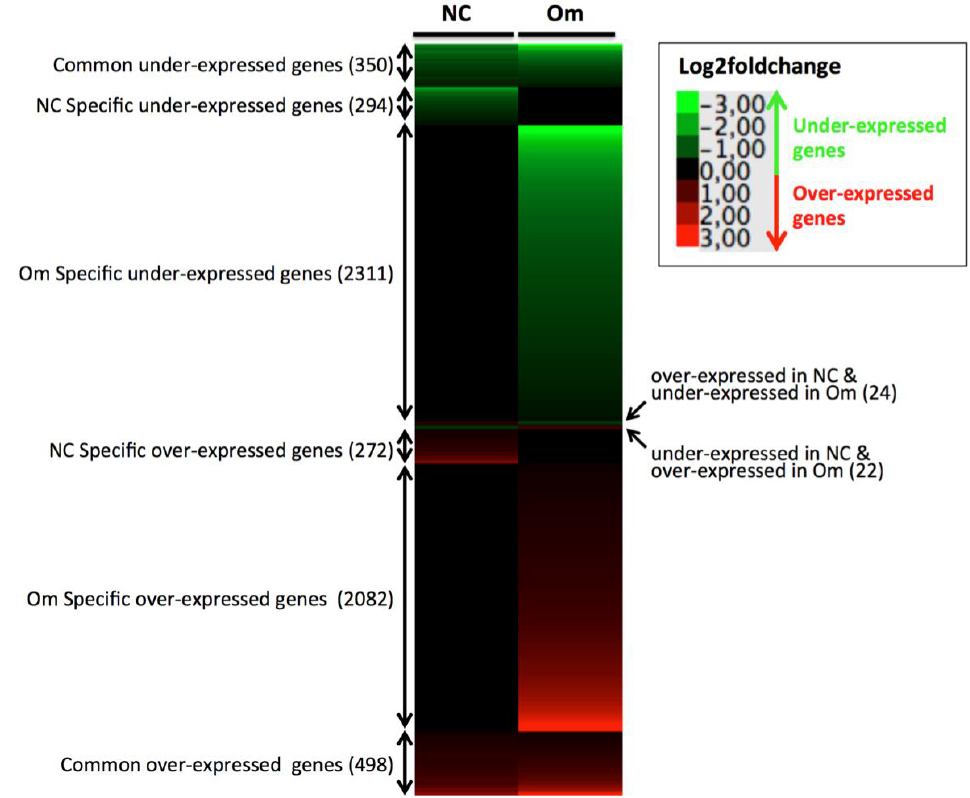
Figure 5 . Heatmap and clustering of significantly differentially expressed genes between the control and the heat stress condition for colonies from each locality. Each gene is represented by a row.